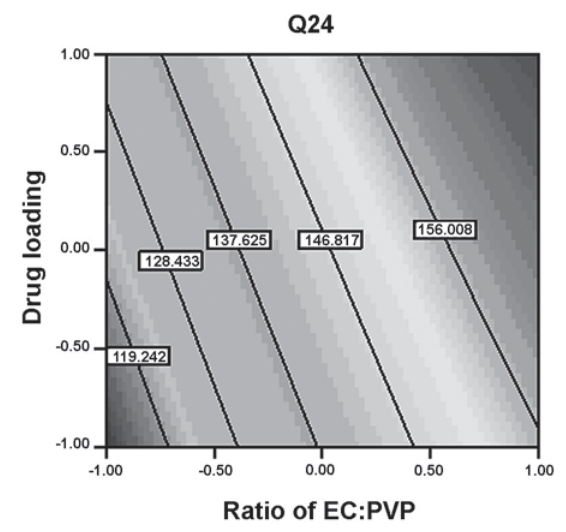
Figure 5 – Response surface plot for amount of drug permeated per cm 2 of human cadaver skin at 24 h (Q of the ratio of EC: PVP and drug loading on Q